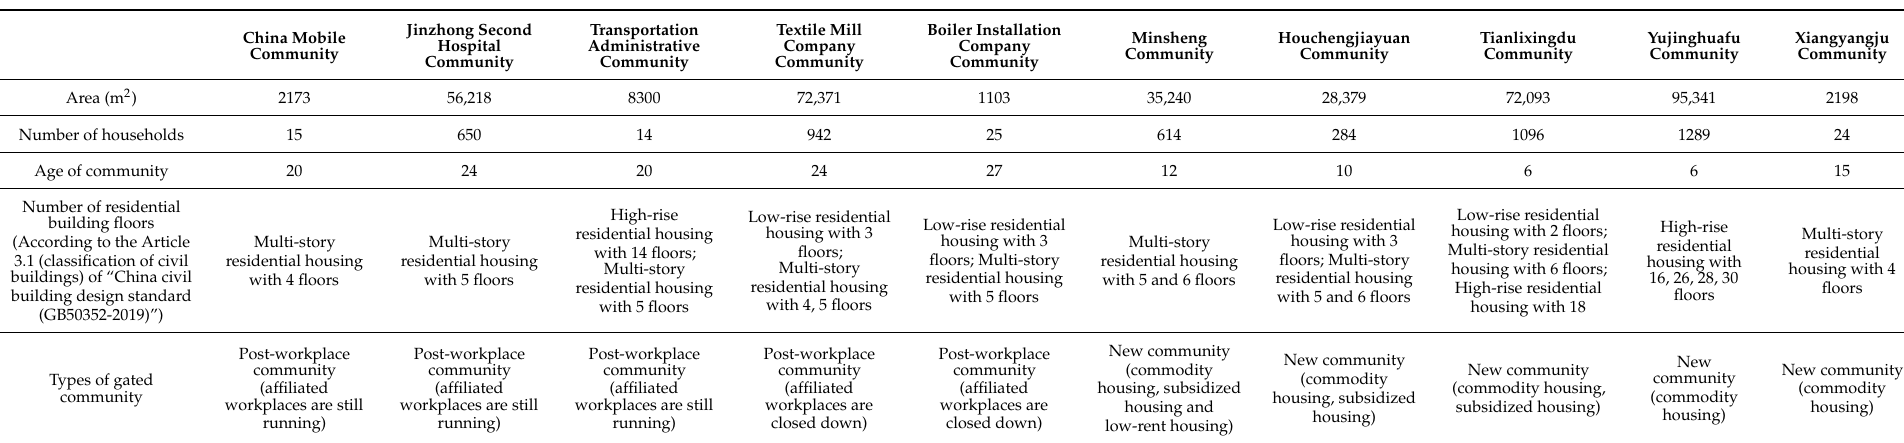
Table 4. Spatial structure and function of the ten gated